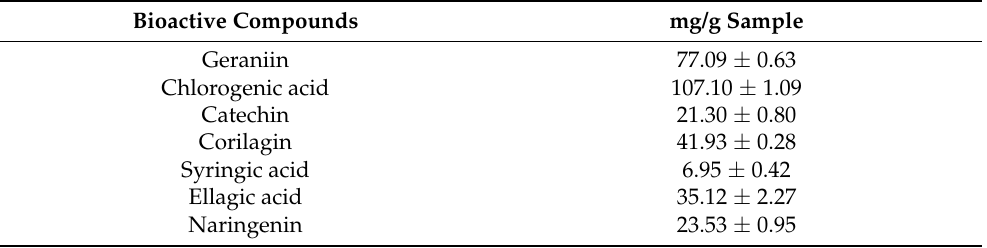
Table 3. The bioactive compounds composition of ethanolic extract of pulasan rind. Bioactive